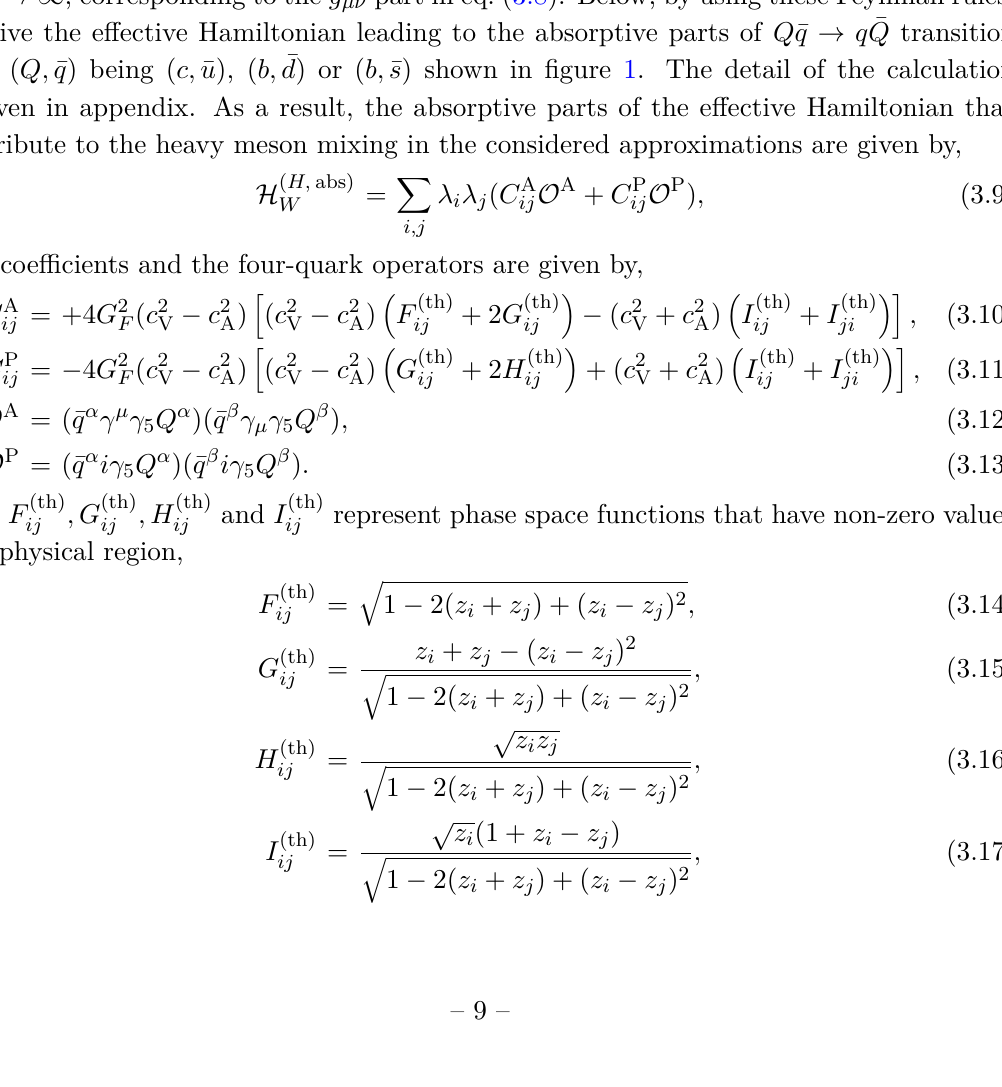
¯ Q with ( Q, ¯ q ) being ( c, ¯ u ) or ( b,